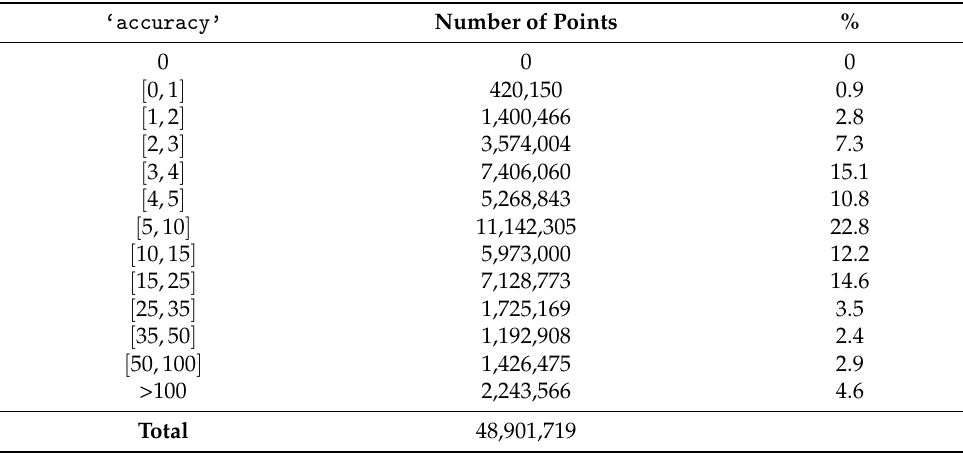
Figure 8. Evolution of the median value of the accuracy of geolocalization (for all measurement points with geolocalization) in function of time, since the first second of measurement. Table 11. Distribution of accuracy for the point with